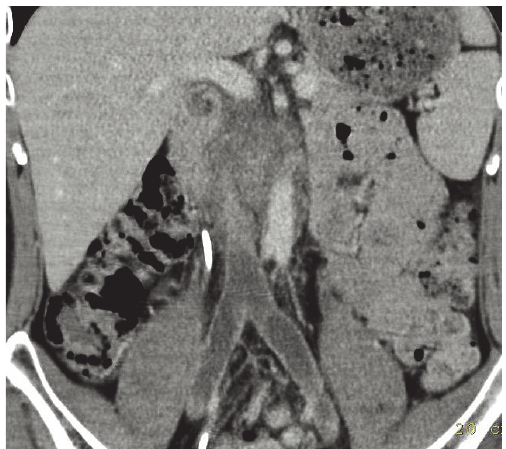
Figure 1: Abdominal computerized tomography showing a large mass in the upper retroperitoneum compressing the vena cava. Thrombotic occlusion of vena cava with extension of intravascular clotting into both iliac veins.